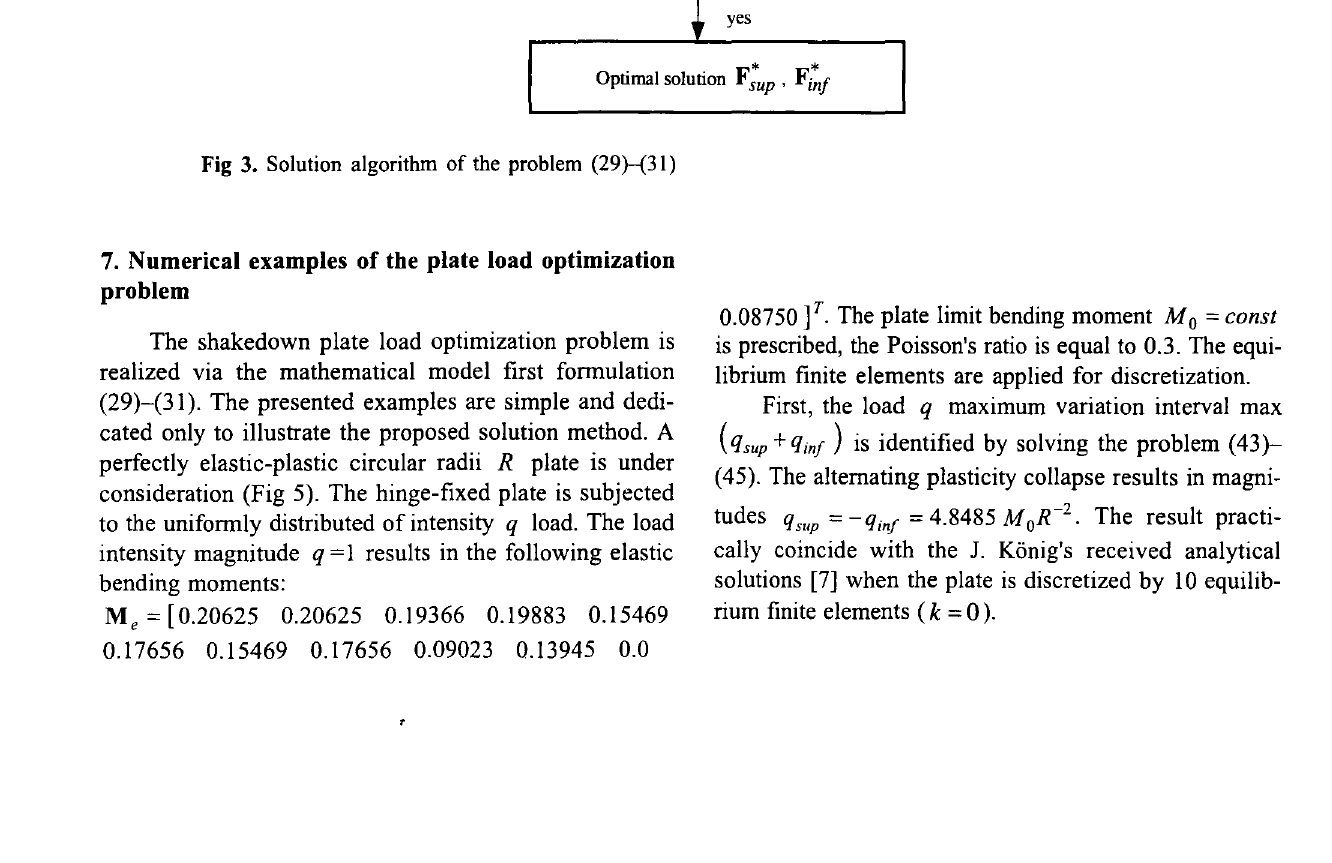
Fig 3. Solution algorithm of the problem